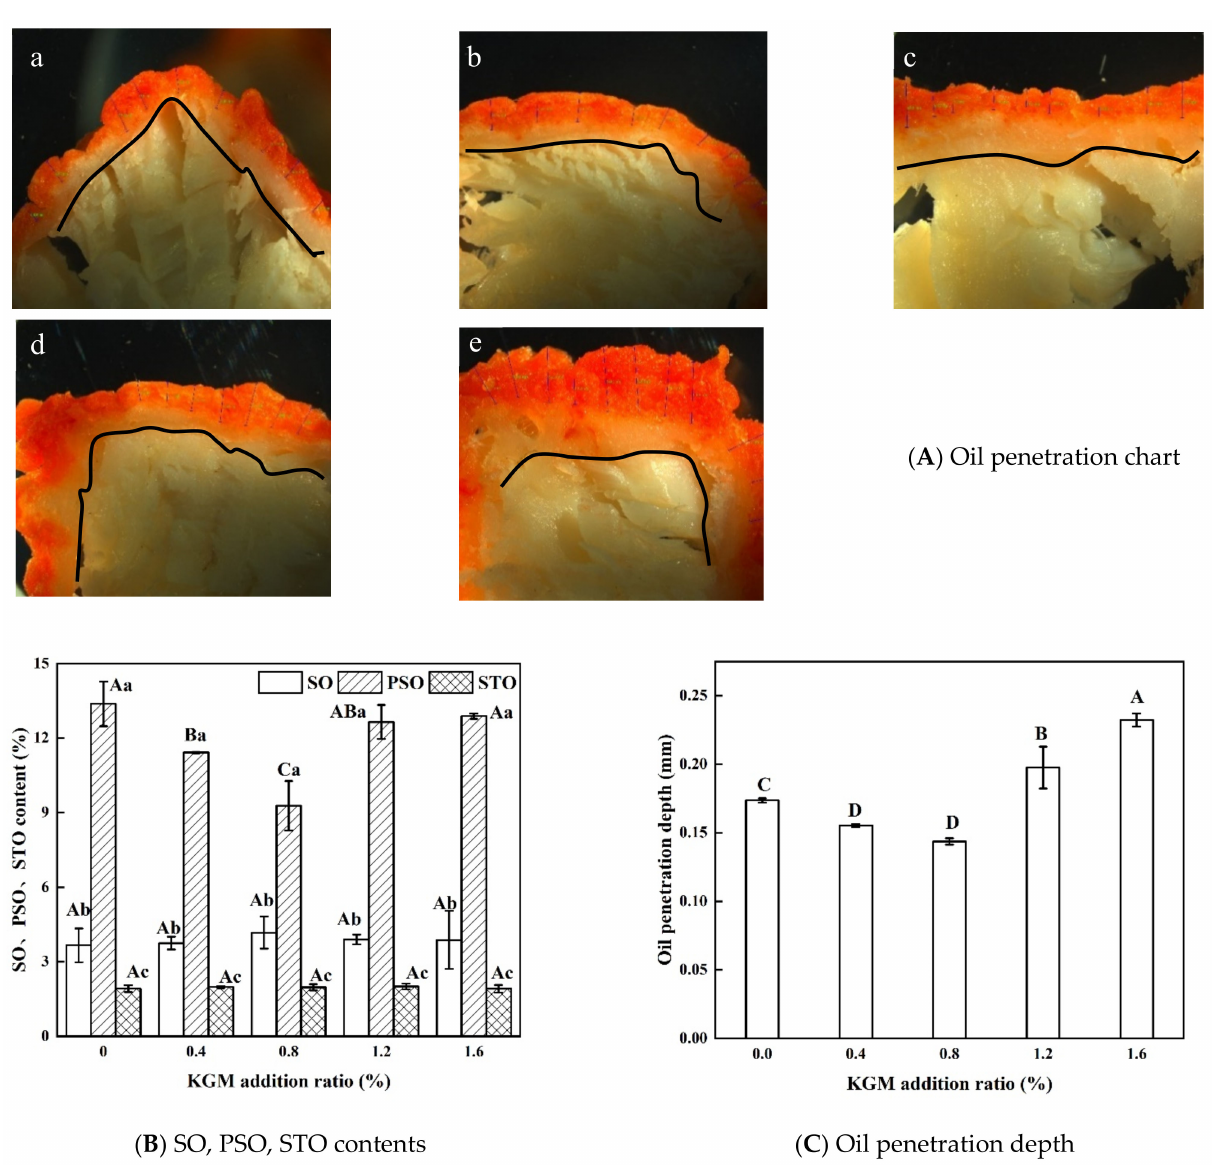
Figure 2. Oil distribution of fried battered fish nuggets with different proportions of KGM. ( A ) Indi- cates the Sudan Red staining of sample. (a–e) indicate the images of samples under 0% KGM, 0.4% KGM, 0.8% KGM, 1.2% KGM and 1.6% KGM, respectively. ( B ) indicates the SO, PSO, STO contents of sample. ( C ) indicates the oil penetration depth of sample. Note: Different capital letters indicate that there are significant differences between different conditions ( p < 0.05). Different lowercase letters indicate that there are significant differences between the crust and the inner layer in the same condition ( p <